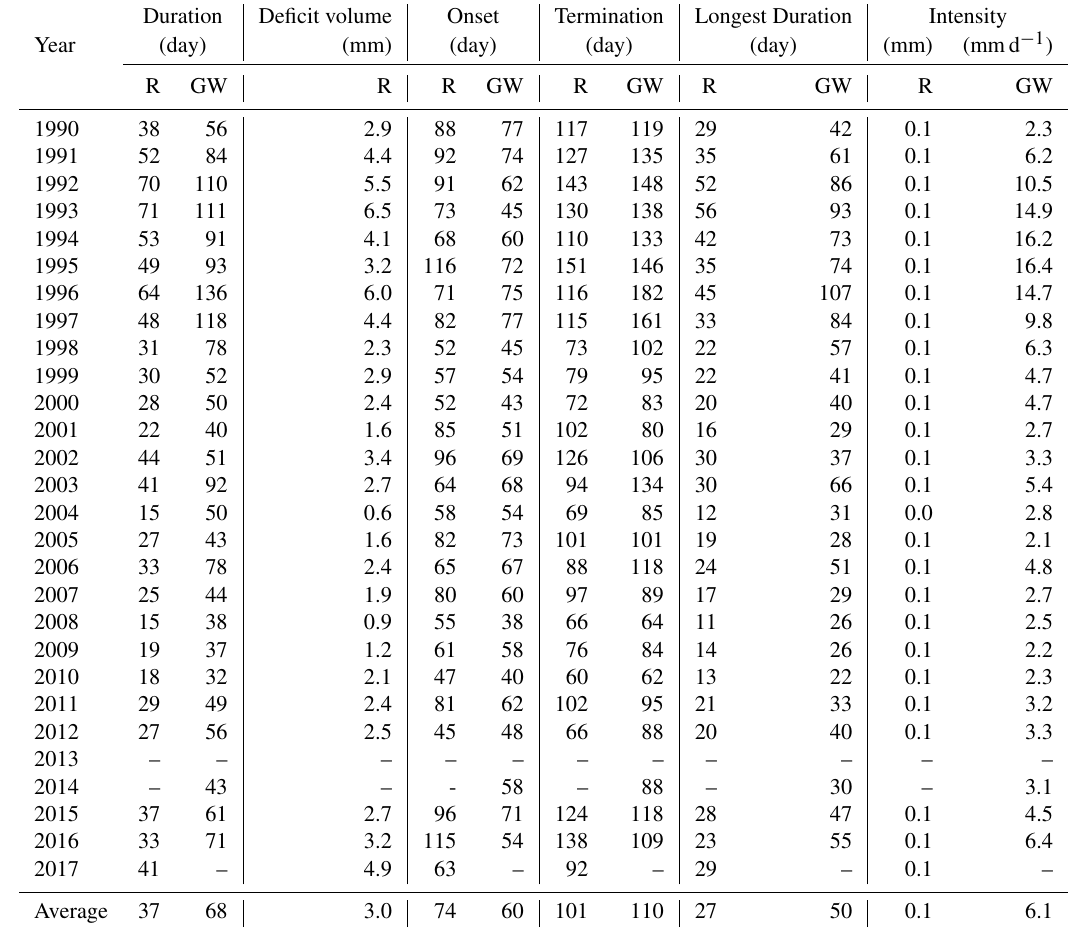
Table 1. Spatially-averaged drought characteristics for each year over the period 1990–2017, which were obtained from drought in runoff (R) and groundwater (GW).